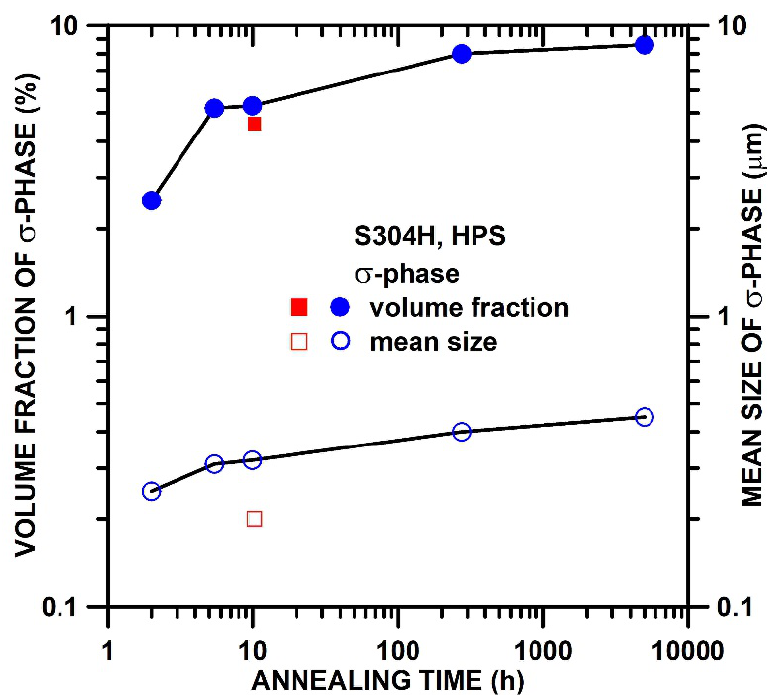
Figure 10. Mean size and amount of σ -phase in HPS-processed microstructure after static annealing at 700 °C and 600 °C. Blue symbols are for 700 °C and red symbols for 600 °C.